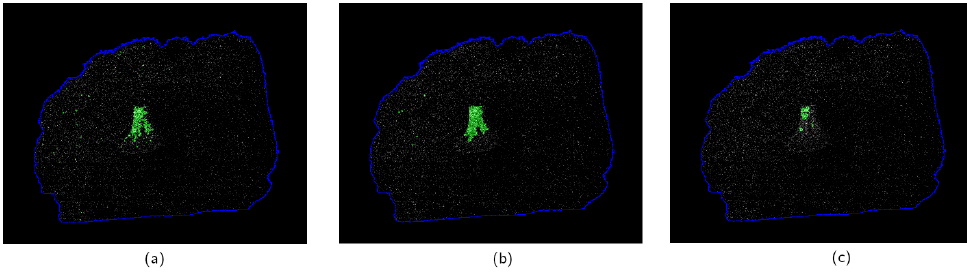
Figure 6. Different examples of the segmentation with different values of penalty weights applied to the N ( x ) image after pre-processing shown on Figure 5c. The panel ( a ) shows a segmentation with low values of penalty weights µ = 1, ν = 1, where many noisy outliers are marked as bone fragments. This effect can be reduced by changing the weights as shown on panel ( b ) corresponding to µ = 5, ν = 1. High values of penalties, such as µ = 20, ν = 5 on panel ( c ) might lead to a safe segmentation excluding a significant fraction of the